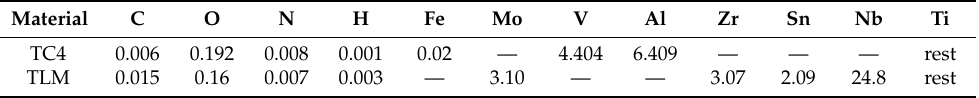
Table 1. The chemical properties (mass %) of Ti6Al4V (TC4) and Ti3Zr2Sn3Mo25Nb